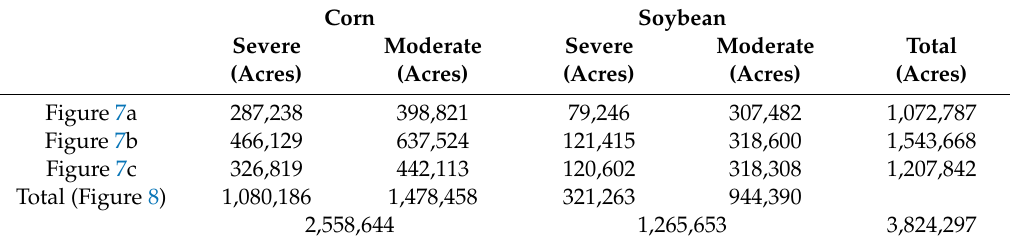
Table 2. Amount of lodged corn and soybean per unit area.